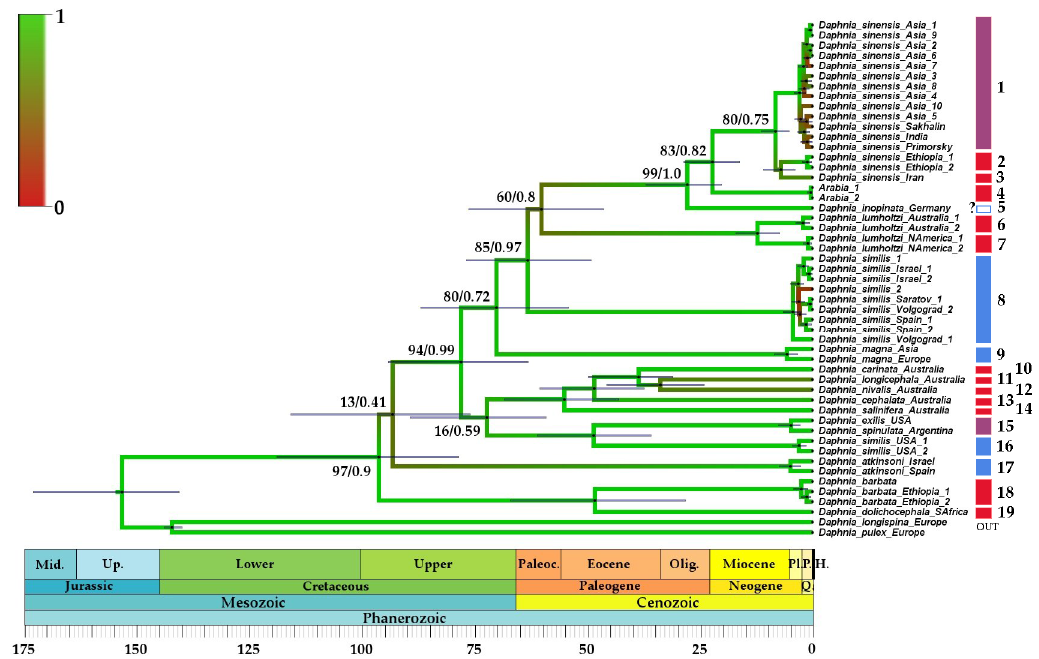
Figure 12. Phylogenetic ultrametric tree based on three mitochondrial genes (12S, 16S, COI) for Daphnia (Ctenodaphnia) with relaxed molecular clock estimates based on fossil calibration points. The bars depict the 95% highest probability density (HPD) interval of the estimated divergence times. Prior probability of branches is coded by the colour gradient from red (low) to green (high). Node supports for key points are: UFboot (ML) for the first digit/value of the SH-aLRT test for the second digits. Results of the STACEY delimitation are represented by bars of different colours on the right side: blue—now inhabit mainly the “Laurasian“ territories, red—mainly inhabit “Gond- wanan“ territories and closest to the former ones (only aborigenous range, not taking into consid- eration recent anthropogenic invasions), purple—distributed through both territories, white with blue frame—invader of unknown origin.The 12S haplotype network (Figure 13) is constructed based on short fragments, it means the number of substitutions have a limited significance for the understanding of the species delimitation. D. similoides , D. inopinata and D. arabica sp. nov. are sep- arated by 4–6 substitutions, but it is not reason to doubt their status as a separate taxa. They form a separate cluster interconnected to the cluster of D. sinensis through the Ethiopian haplotype which is also interconnected with the Mediterranean and mainly Mediterranean haplotypes, one of which then interconnected to the haplotypes from North-East Asia and India. The Iranian haplotype is separated from other D. sinensis haplotypes by at least four mutations, as observed in its specific position on the tree also (Figures 12 and 13). Note that the Middle East, North Africa and India are rich in haplotypes which are endemic to particular regions. In contrast to D. similoides , D. inopinata and D. arabica sp. nov., D. sinensis s. str. has several widely distributed haplotypes separated by single mutations. The network of D. sinensis group corresponds in general to the tree in Figure 12. Other species are well-separated in the network from the D. sinensis group, and its closest congener is D. lumholtzi (as in the tree), while D. similis is grouped with D. cf. similis from North America (= D. exilis group) and D. magna .